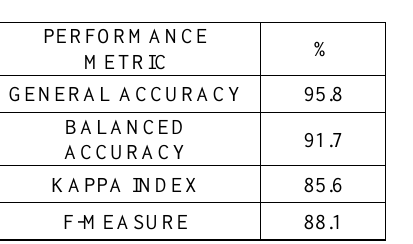
Table 3. Performance